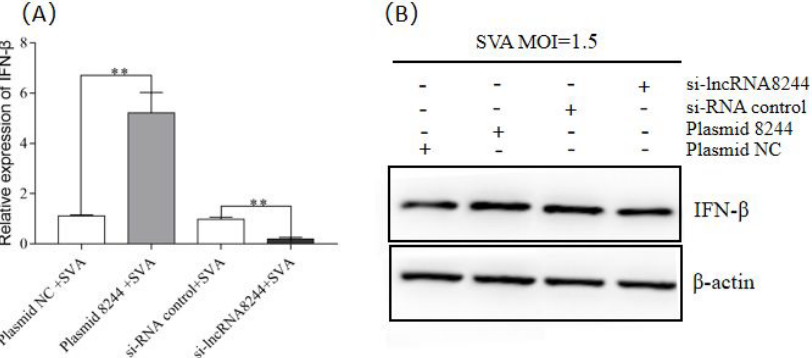
Figure 1. The expression of lncRNA 8244 in cells or clinical samples. ( A ) PK-15 cells were infected or no-infected with SVA (MOI = 0.3, 1, 1.5, 3, 4.5) for 24 h. Total RNA was extracted to determine the relative mRNA expression of lncRNA 8244 by real-time RT-PCR assay. ( B ) PK-15 cells were no-infected or infected with SVA (MOI = 1.5). The mRNA expression of lncRNA 8244 at 3, 6, 9, 12, 24, 36 hpi. ( C ) The expression level of lncRNA 8244. ( D ) Expression of lncRNA 8244 in clinical samples of SVA-infected piglets. Total RNA was extracted to determine the relative mRNA expression of lncRNA 8244 with real-time RT-PCR assay. All data are represented as mean ± SD with three replicates. ** p < 0.01.